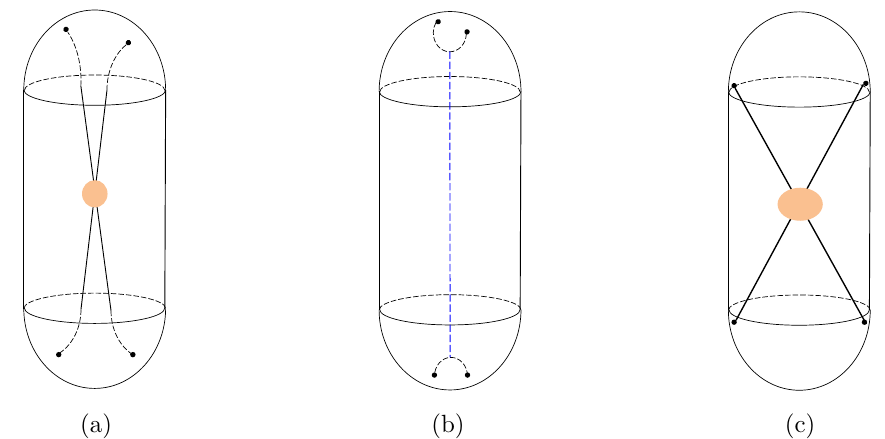
Figure 4. Geodesic configurations and flat-space scattering. (a) The geodesics that describe the flat-space scattering in the large R limit. Two particles emitted from the operators in the lower Euclidean cap first tunnel to the Lorentzian cylinder, then scatter at the center of AdS and tunnel back to the upper Euclidean cap. (b) The geodesics that give a dominant contribution when two operators are close to each other. Two operators in the lower cap are directly connected by a Euclidean geodesic, and so are the operators in the upper cap. These two geodesics can also be connected by an exchange of some light particle (denoted by a blue dashed line). (c) The geodesics relevant for the bulk point limit which corresponds to | k 0 | → ∞ in our setup. When two operators are close to the edge of the lower cap, the dominant contribution is given by geodesics which connect four operators in the Lorentzian